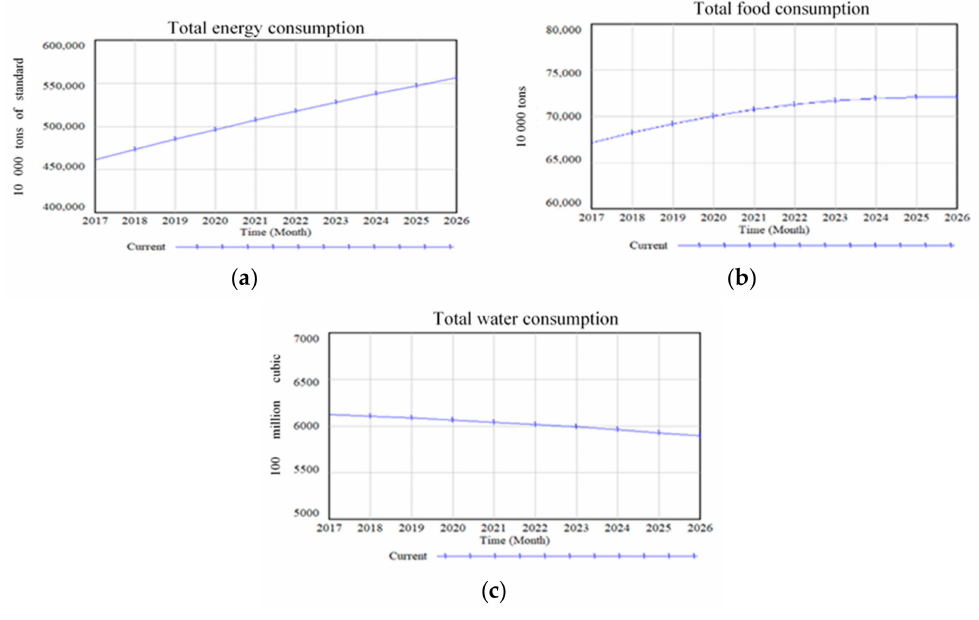
Figure 6. Predictive simulation